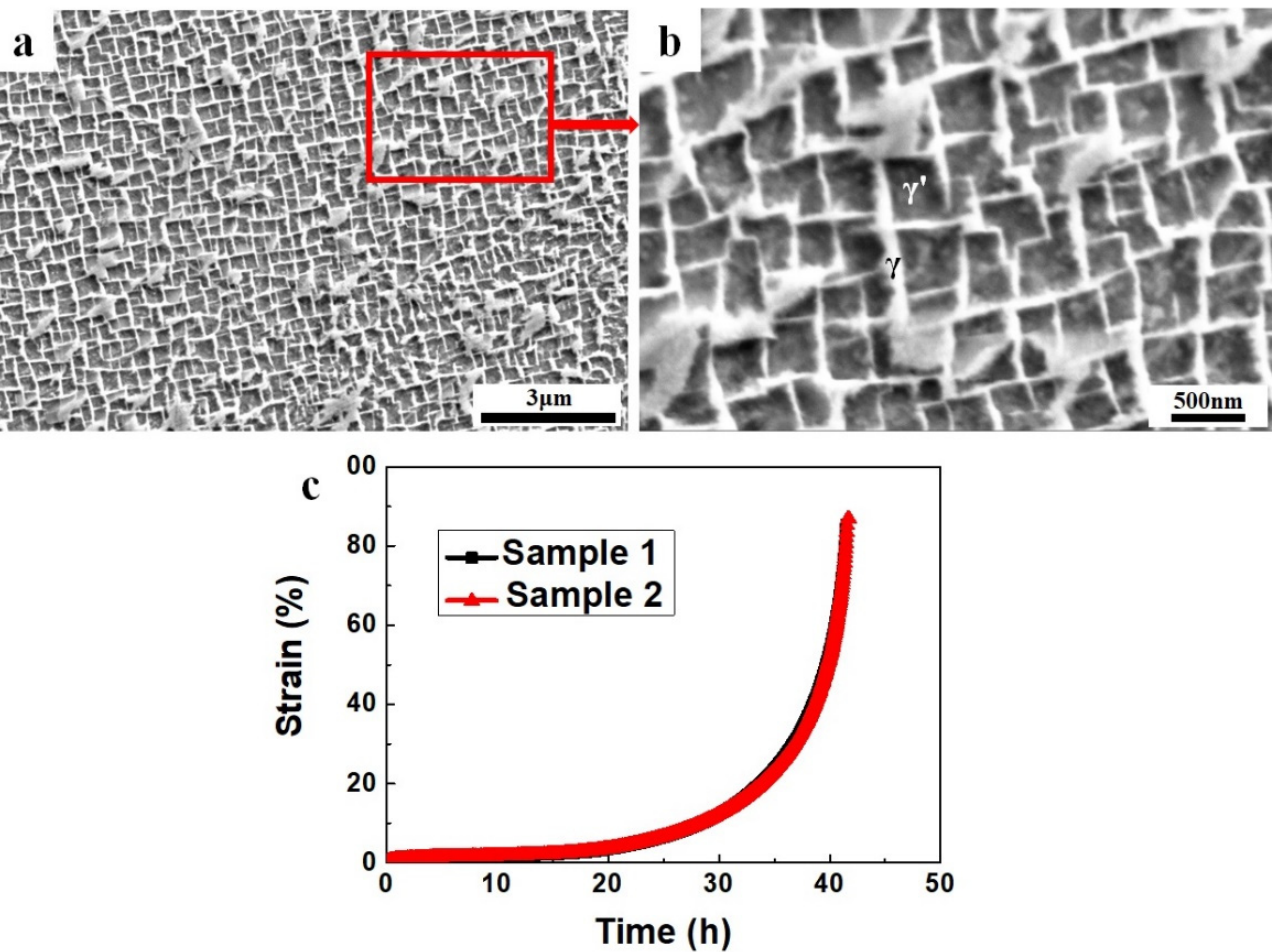
Figure 1. ( a ) Microstructure of the Al–Mo–rich Ni–based SC superalloy; ( b ) enlarged image of ( a ) showing γ phase and γ ’ phase; ( c ) creep time–strain curve under 1100 °C/140 MPa.